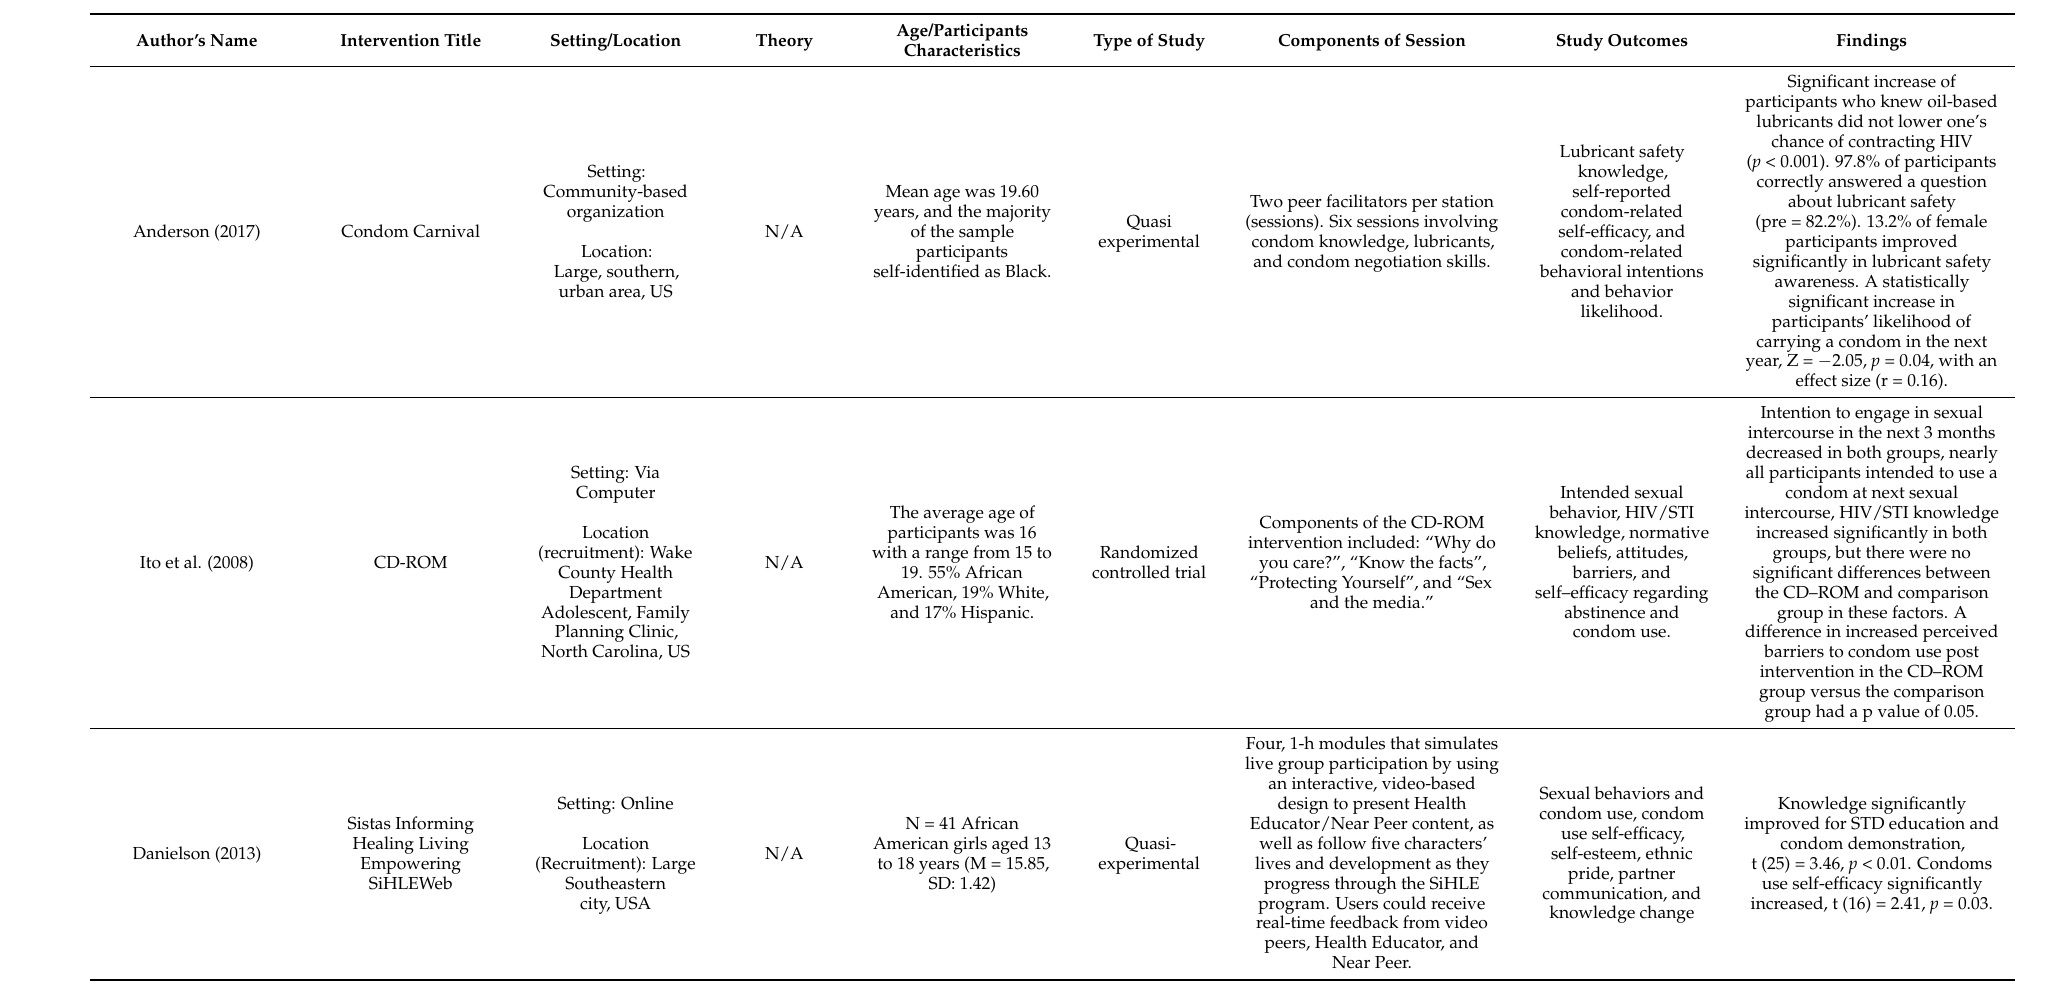
Table 1. Interventions that were included in the